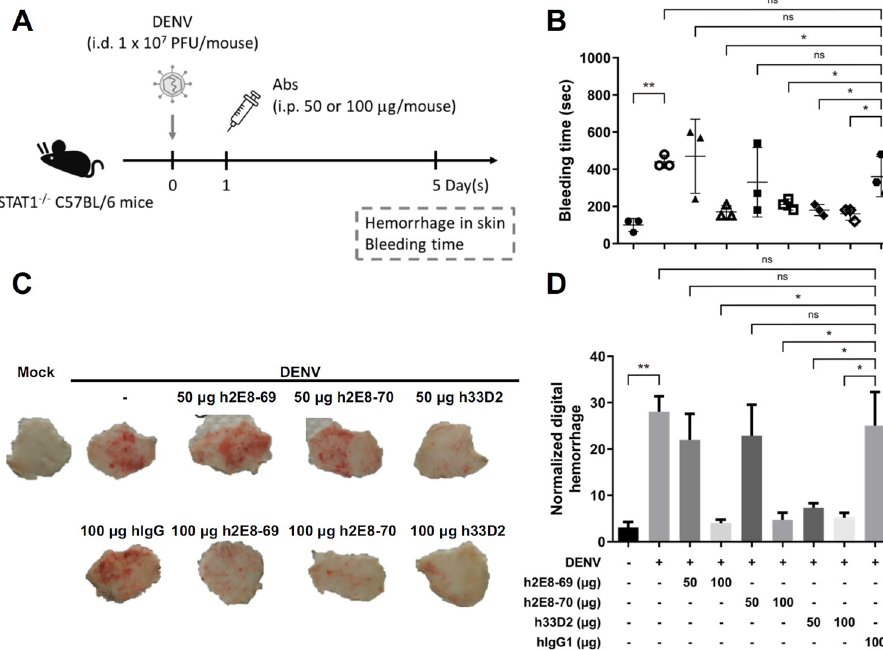
Fig 2. Administration of humanized anti-NS1 mAbs 2E8 and 33D2 can shorten DENV-induced prolonged bleeding time and reduce skin hemorrhage. ( A ) The schematic model illustrates the therapeutic treatment of mice. 1 × 10 7 PFU/mouse DENV2-454009A or C6/36 control medium were inoculated i.d. into the upper back of STAT1 -/- mice. The mAbs h2E8-69, h2E8-70, h33D2, or isotype control hIgG1 (50 or 100 μ g/mouse) were injected i.p. one day after virus challenge. ( B ) The tail bleeding time was determined on 5 d.p.i. (n = 3 for each group) (C) Mice were sacrificed on day 5, and the fresh skin samples were obtained from the upper back to observe local skin hemorrhage. ( D ) The degree of hemorrhage was quantified by ImageJ software analysis as described in the methods. (n = 4 for 100 μ g hIgG1 and n = 5 for other groups) � : p < 0.05, �� : p < 0.01, ns indicates not significant, as analyzed by one-way ANOVA and followed by Tukey’s multiple comparison